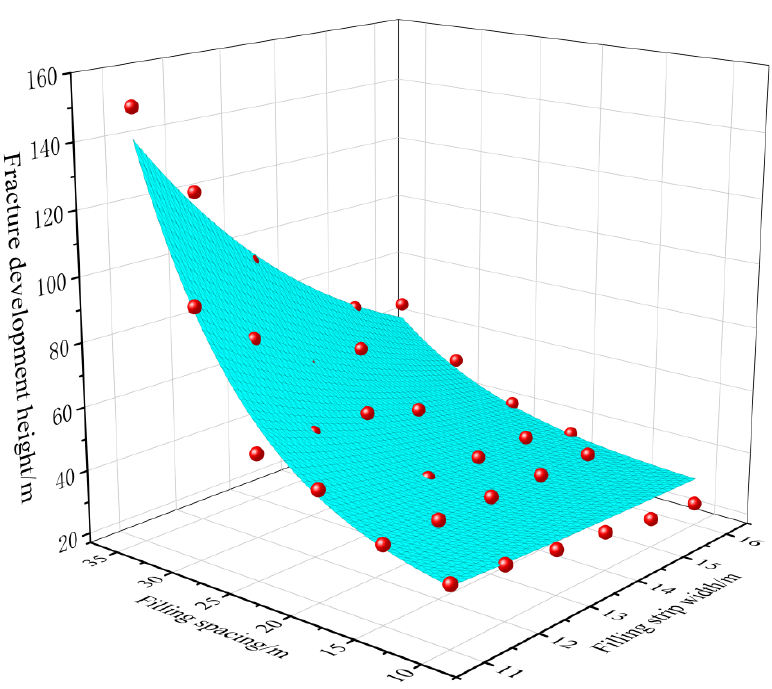
Figure 12. Fitting surface of different filling spacings, filling strip widths and overburden fracture propagation heights.